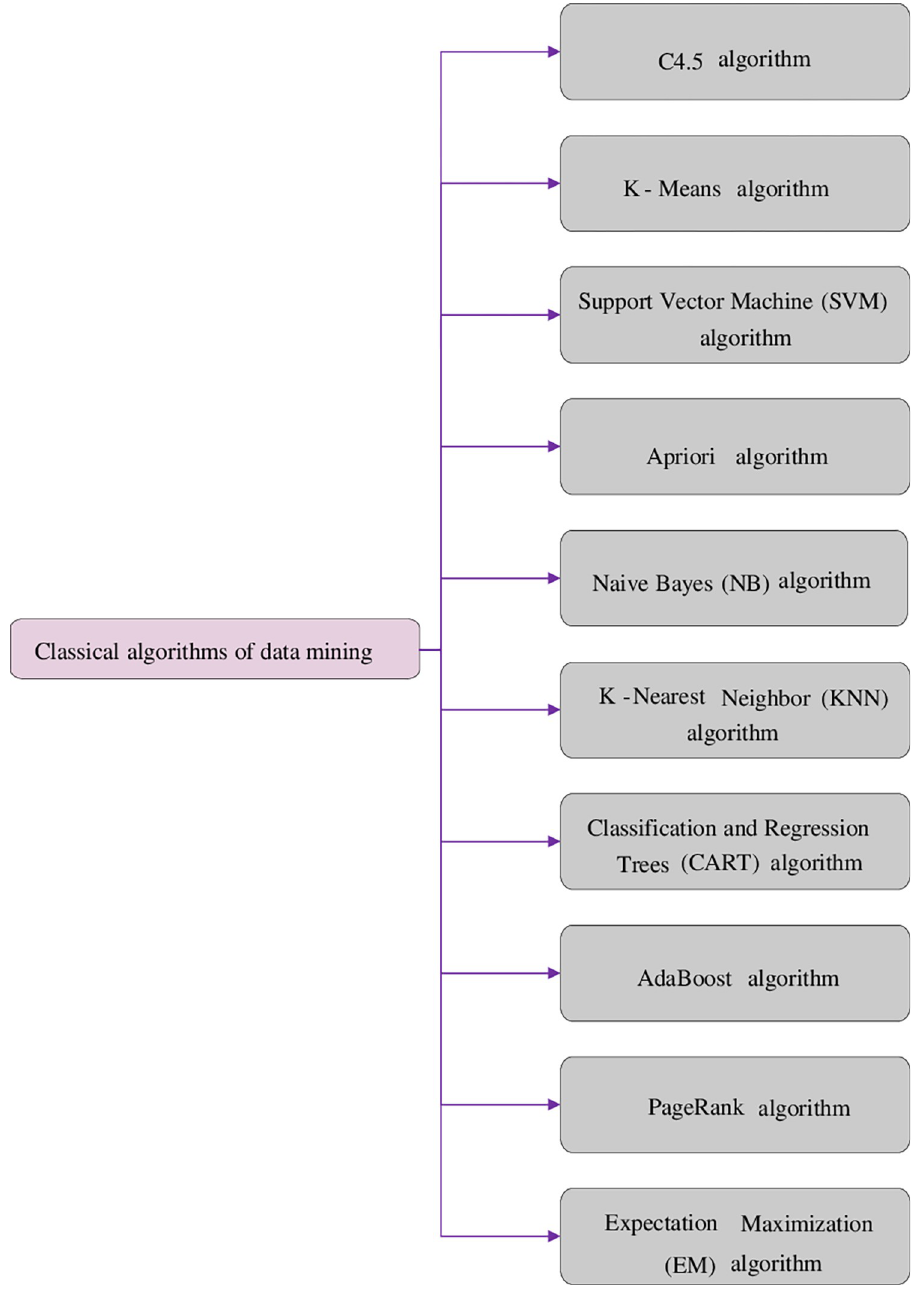
Fig 1. Classical data mining